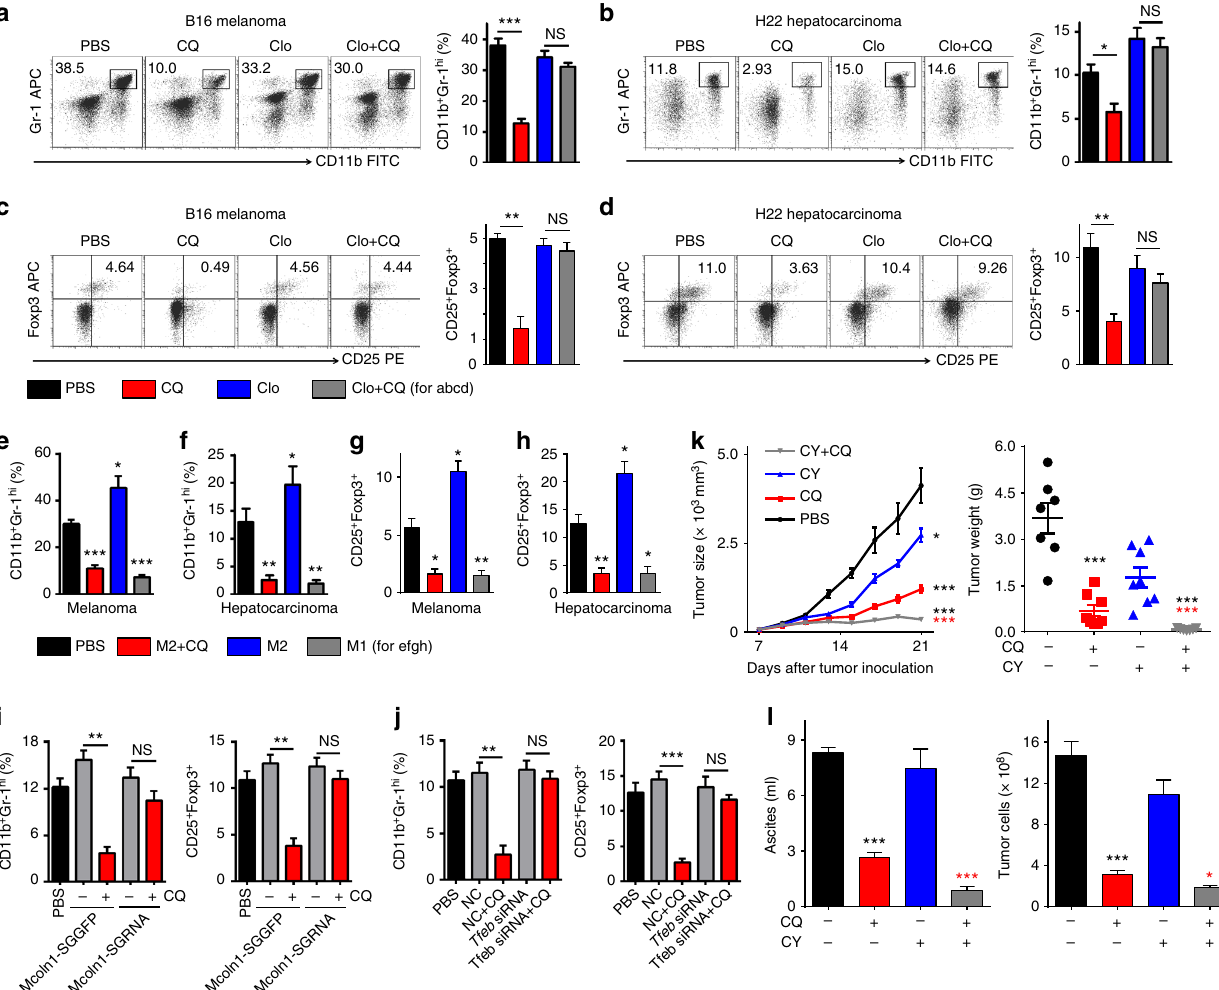
Fig. 7 CQ-reset macrophages ameliorate tumor immunosuppression. a , b , c , d C57BL/6 mice bearing subcutaneous B16 melanoma and BALB/c